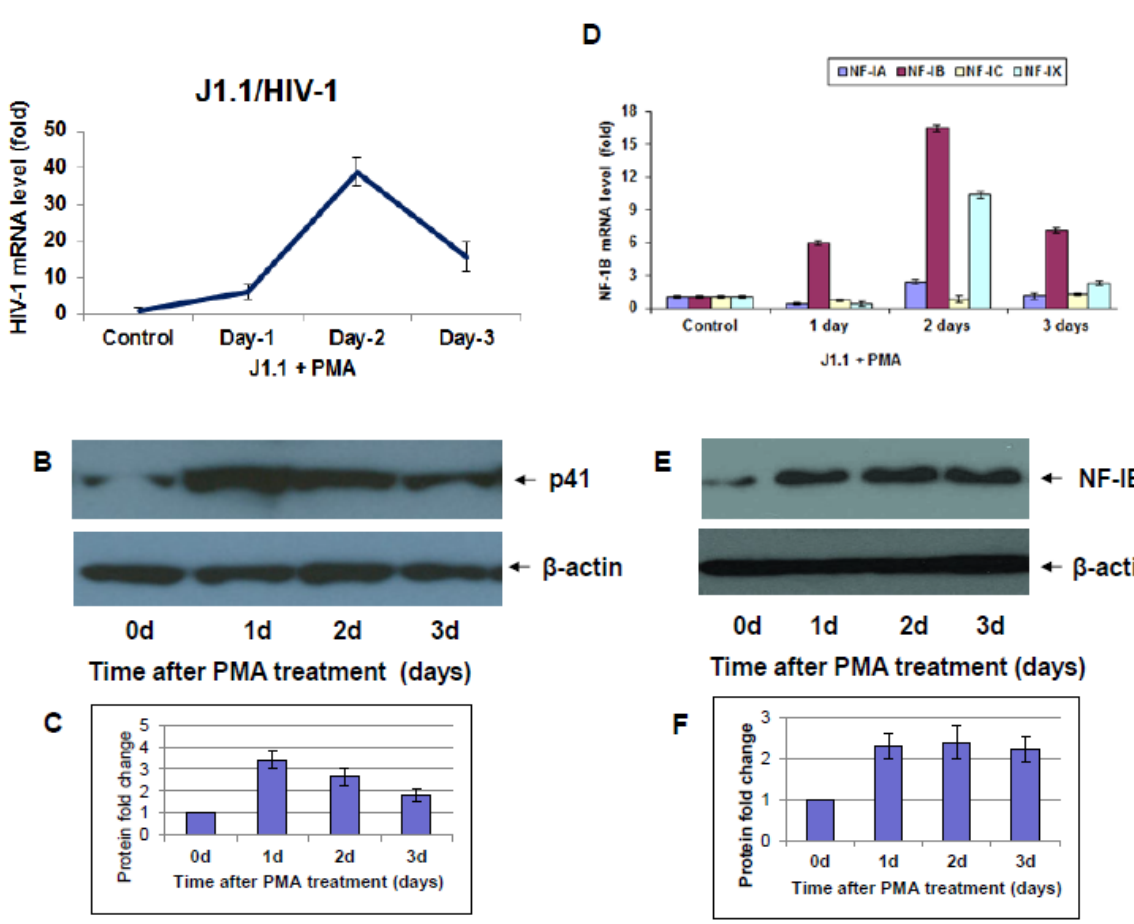
Figure 4. HIV-1 and NF-IB levels in J1.1 cells following PMA activation. J1.1 cells were stimulated with PMA and at indicated time points, cells were harvested to measure HIV-1 ( A , B ), and NF-IB ( D , E ) levels. The data in Figure 4A,D were normalized to GAPDH levels and represent the mean ± SEM from three experiments . ( C , F ) Quantification of signals from Western blots was done using Image J software. Fold change is relative to the 0 d time point. Data are averages of Western blot quantifications ± SEM. Representative Western blots are